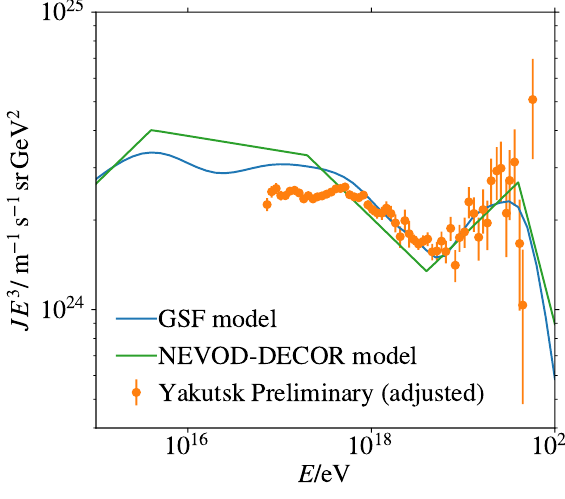
Figure 5. All-particle flux from GSF [38] and NEVOD- DECOR [32] models, and a preliminary update of the Yakutsk spectrum (see Pravdin et al. for the last publication [39]), which was adjusted by an energy-scale factor 1.15 to match the GSF.